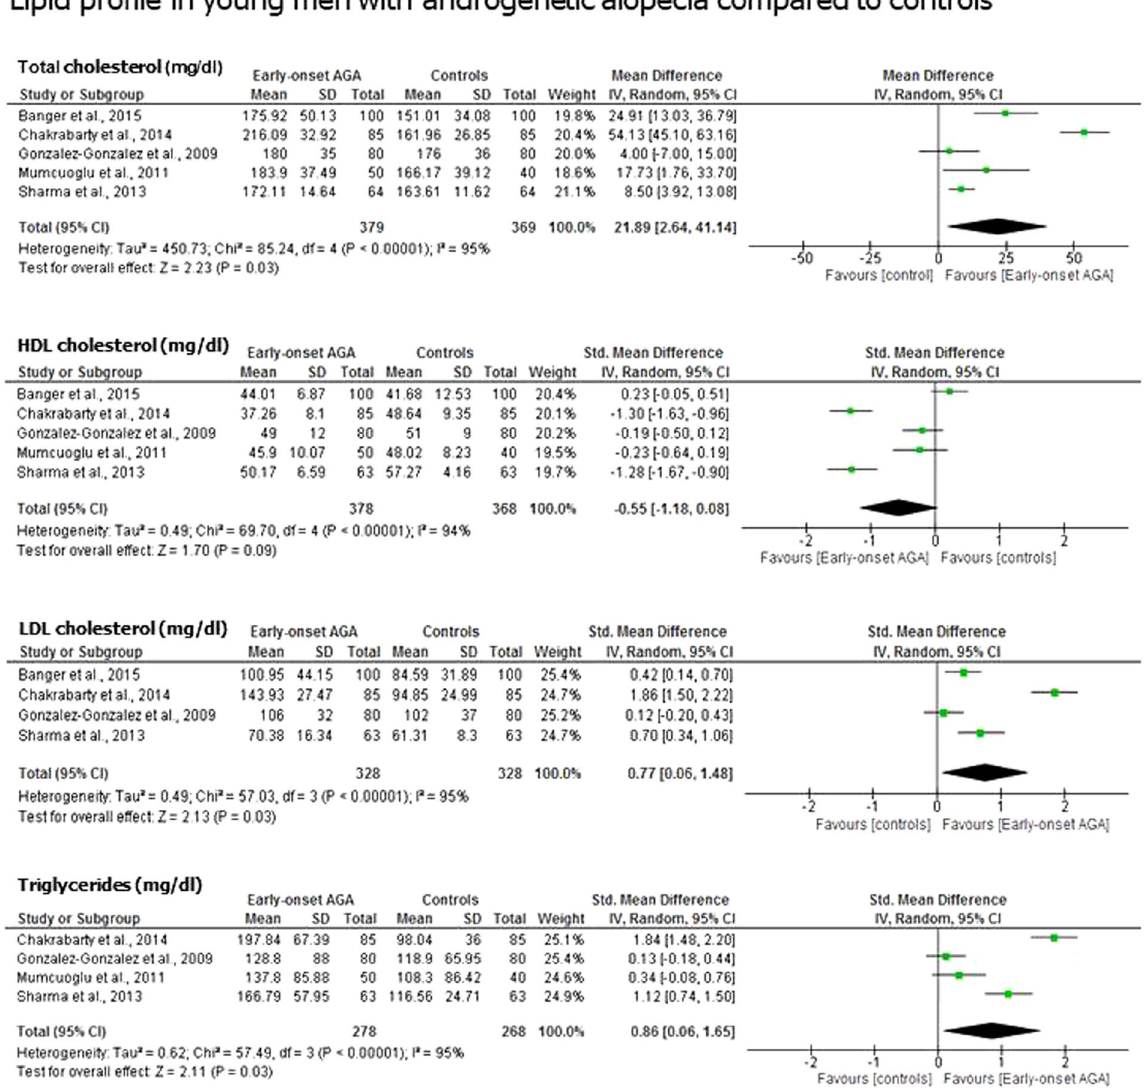
Figure 3. Lipid profile in young men with androgenetic alopecia compared to controls. Men with early-onset androgenetic alopecia younger than thirty-five years old showed significantly higher total cholesterol, LDL cholesterol and triglycerides compared to controls. Also a downward trend for the HDL cholesterol levels was found. Total cholesterol, LDL and HDL cholesterol and triglycerides were expressed in